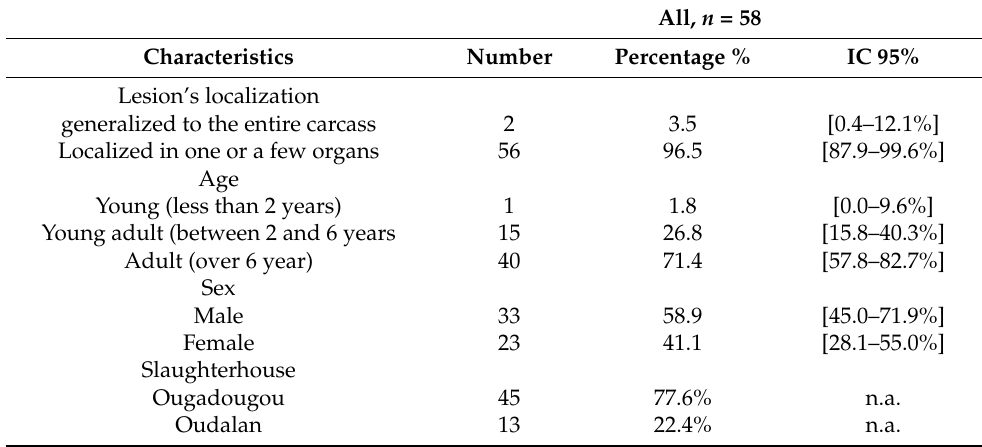
Table 1. Characteristics of the animals with suspicious lesions.